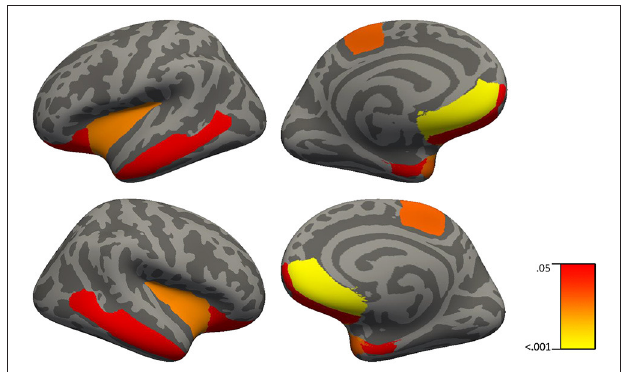
FIGURE 2 | Brain regions in which C-reactive protein significantly predict cortical thickness in 51 healthy controls and 41 patients with schizophrenia using simple linear regressions with backward elimination (regions highlighted represent significant effects at FDR p <